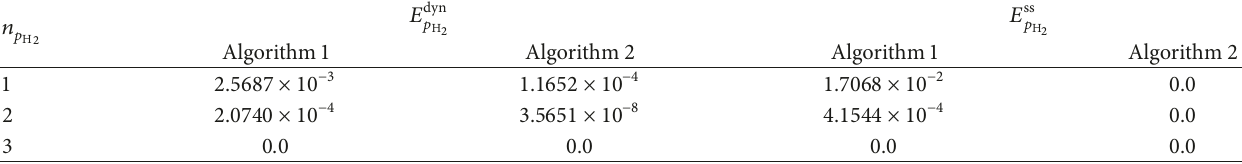
and the steady-state error 𝐸 ss 𝑝 H 2